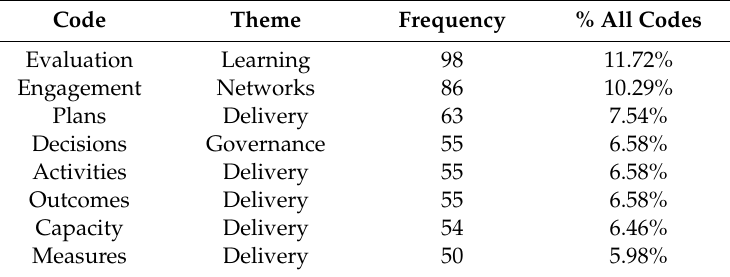
Table 8. Code allocation summary: Most